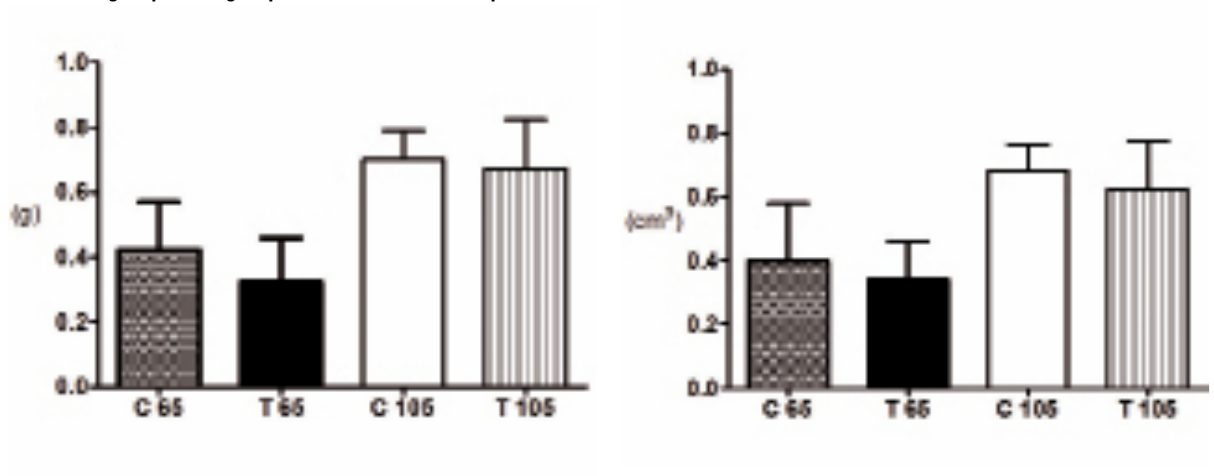
Figure 2 - Comparative graphs between prostate ventral lobe weight (g) and volume (cm3) of treated and control rats. Data expressed as mean and sD. p < 0.05. The analysis showed difference between C65 and T65 groups, as well as between C105 and T105 groups. weight: p < 0.001 and volume: p =